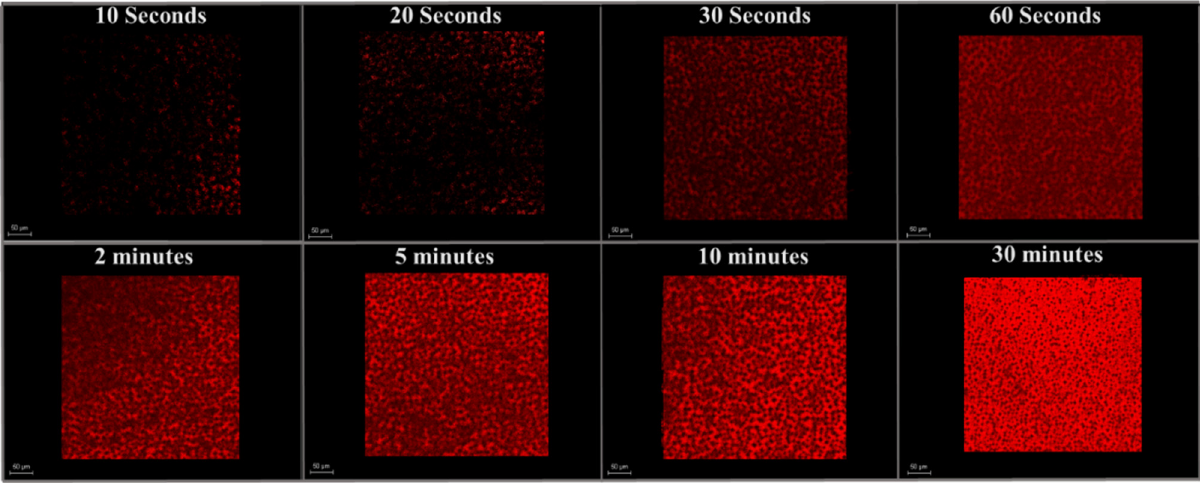
Figure 8. Fouling profile images of BSA at eight filtration times on the surface of an as-received membrane. Scale bar is 50 μ m.